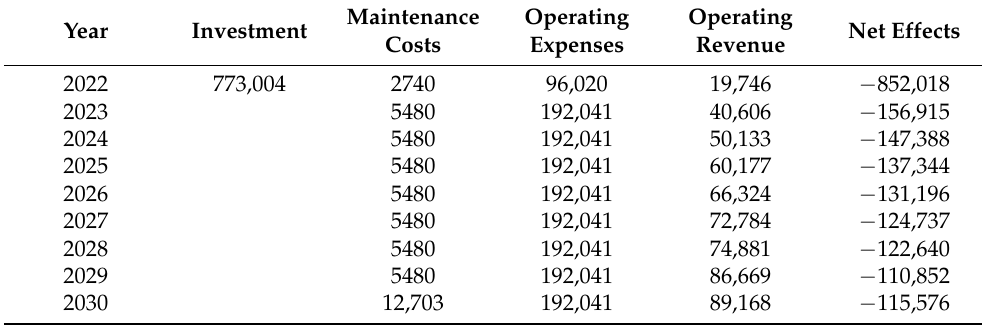
Table 7. Forecast of the economic flow of the project (in EUR).